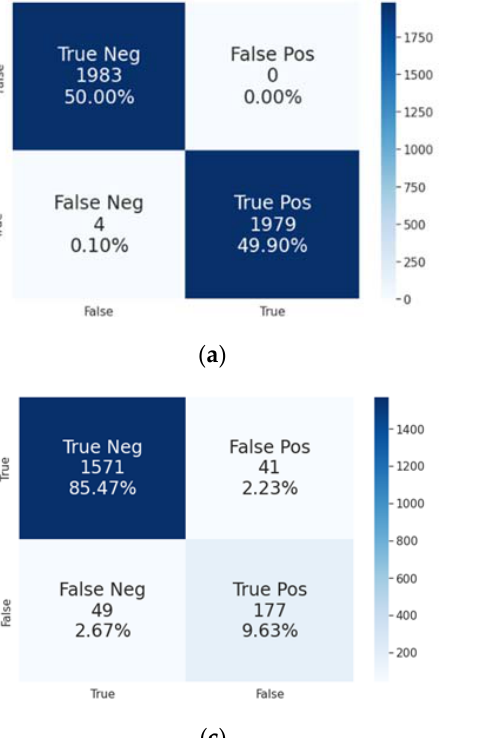
Figure 9. Confusion matrices for the: ( a ) training data from the MIT ‐ BIH database; ( b ) testing data collected from the ambulatory sensor (Savvy ECG); ( c ) NSR testing data from the INCART data ‐ base; ( d ) PVC training and testing data from the INCART database.